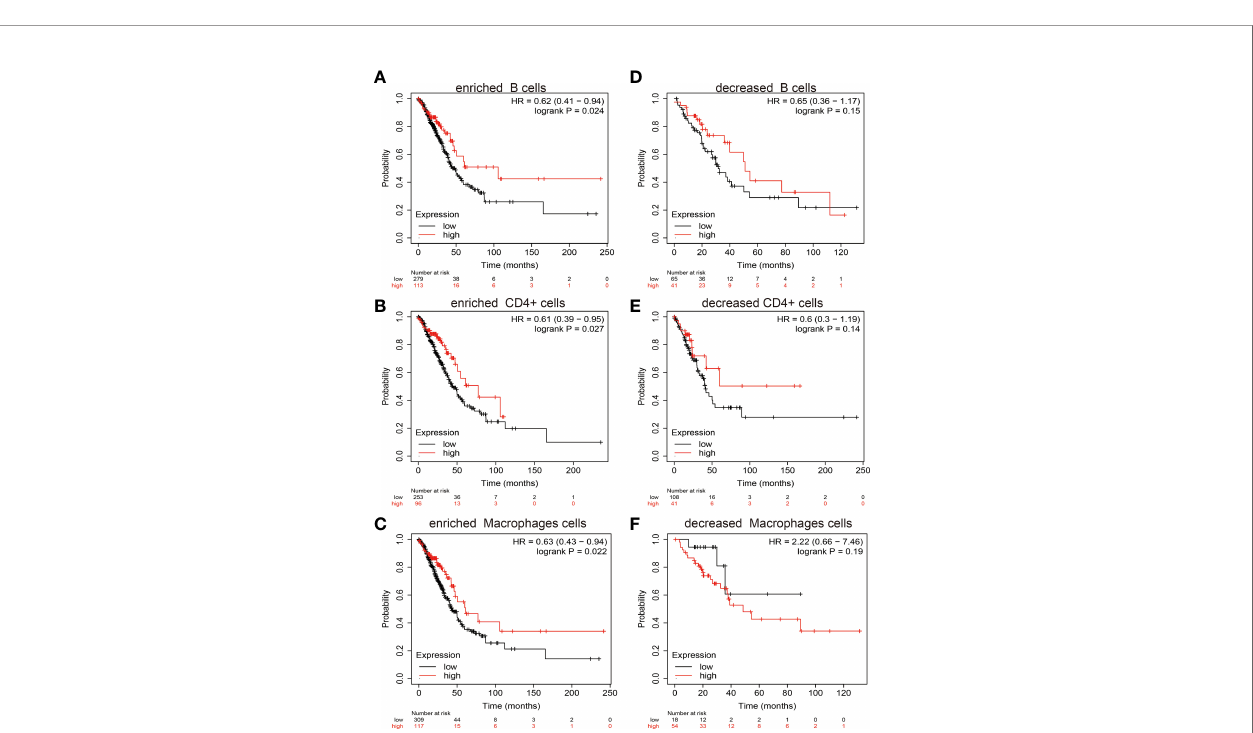
FIGURE 12 | Overall survival curves based on the expression of miRNA-30a-5p in the immune cell subgroups in LUAD. (A – F) Correlation between miRNA-30a-5p expression and overall survival in different immune cell in fi ltration groups in LUAD